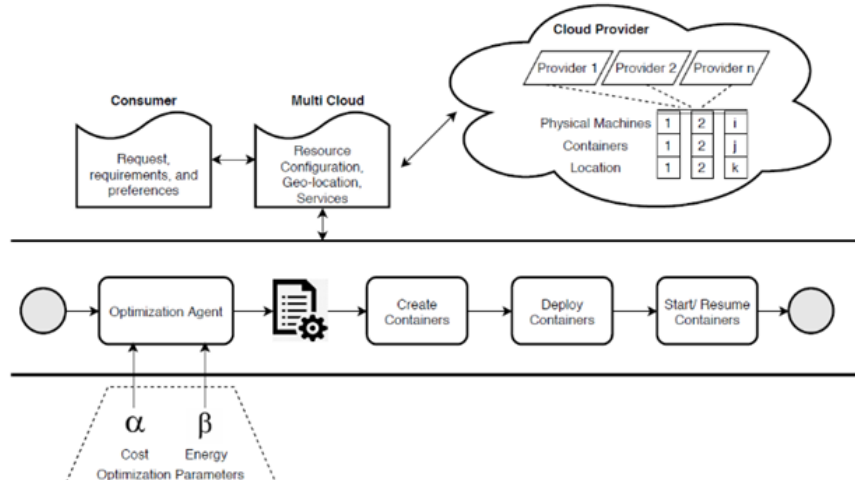
Figure 10. Resource optimization schema.